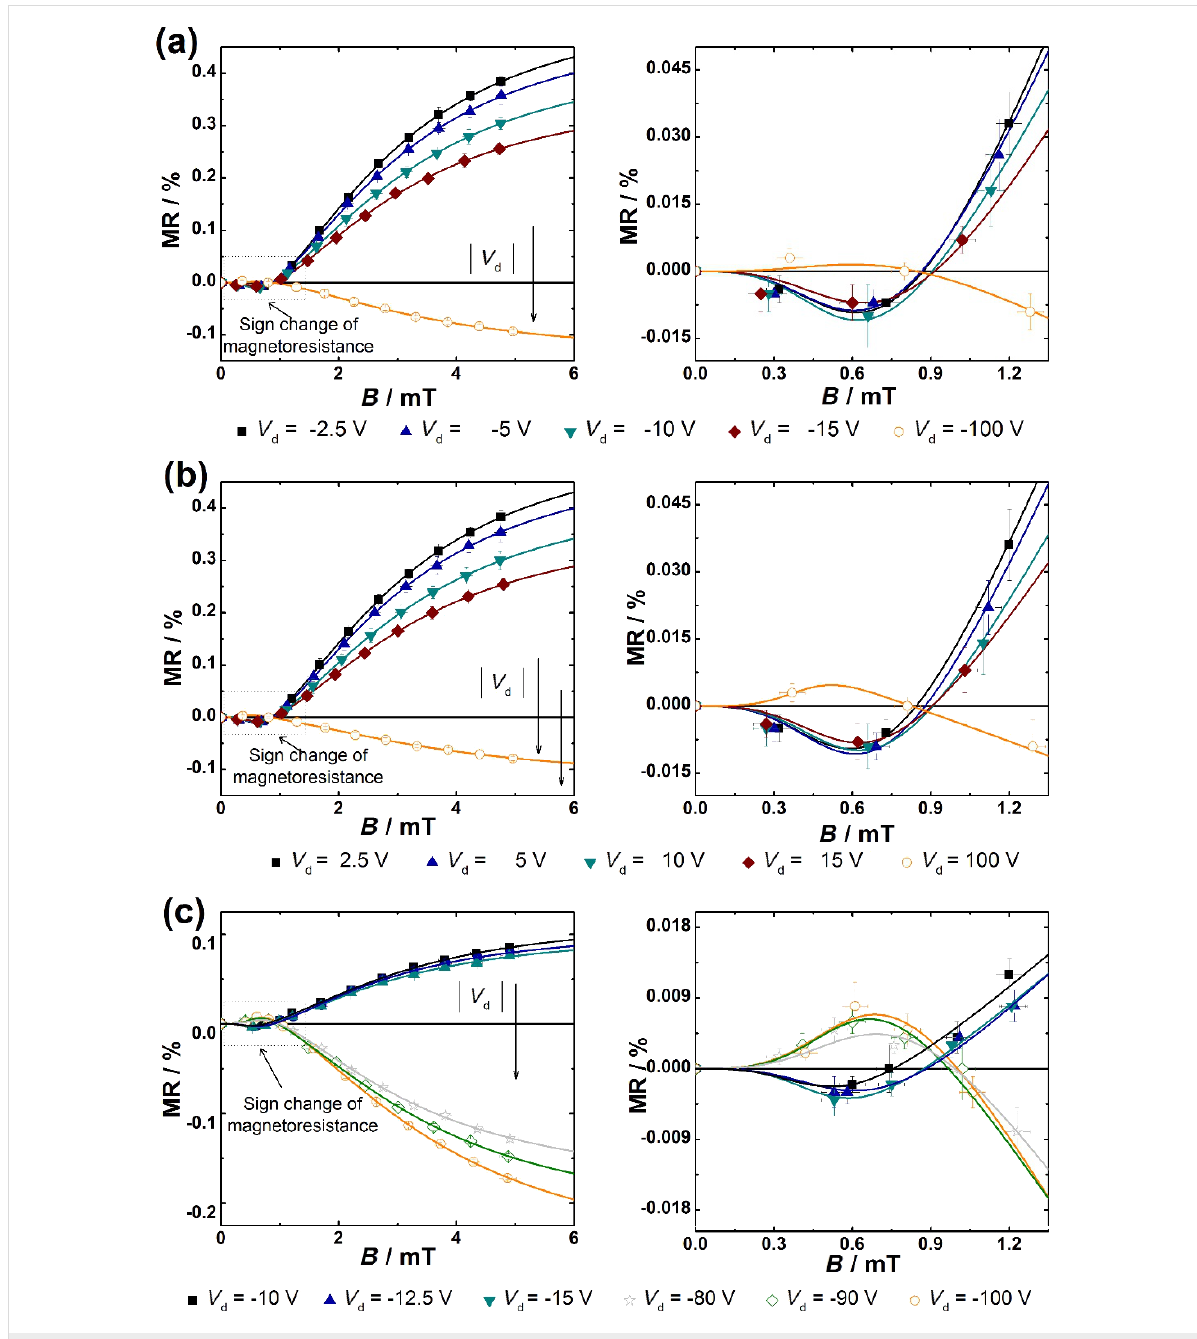
Figure 8: Ultrasmall magnetic field effects obtained for different compositions of Spiro-TTB/HAT-CN systems with a mixing ratio of (a) and (b) 51:49 and (c) 78:22 [19]. The measurements were performed at different values of V d while keeping V g constant at zero voltage. The solid lines are the fitting curves according to Equation